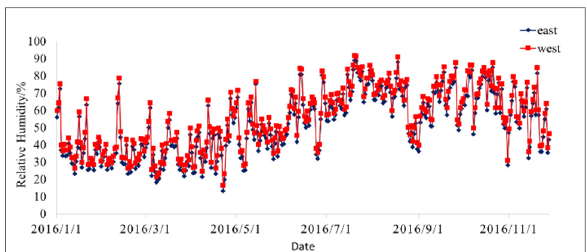
Figure 3: Relative humidity comparison